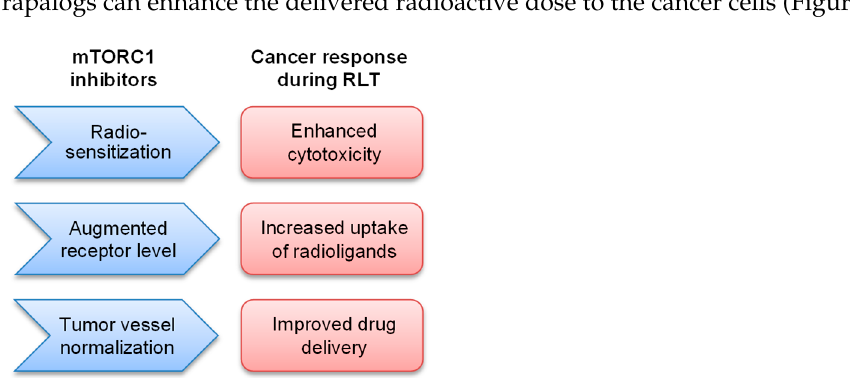
Figure 2. Potential of mTORC1 inhibitors to improve the efficacy of cancer RLT. Inhibition of mTORC1 sensitizes cancer cells and the microenvironment to ionizing radiation and enhances cytotoxicity. In addition, mTORC1 inhibitors can increase the level of the target receptors, as well as normalize tumor blood vessels, leading to increased cellular uptake and drug delivery.